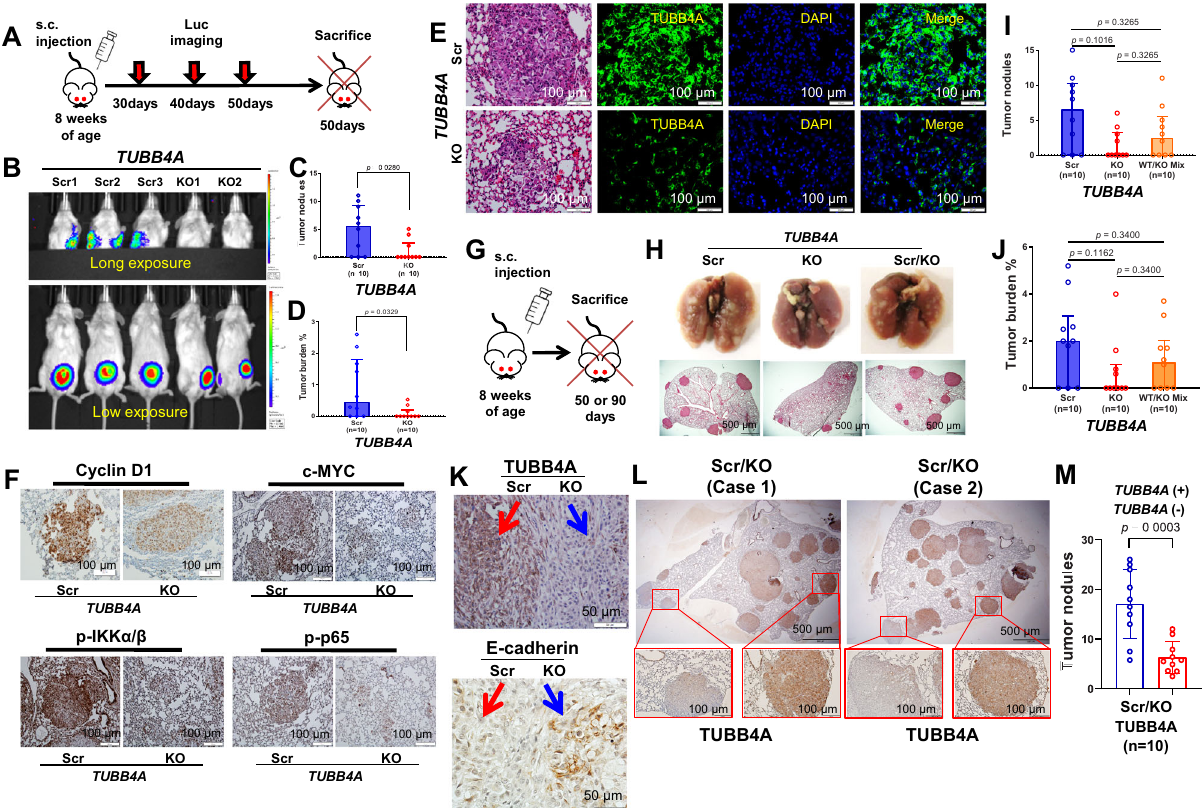
Fig. 7 TUBB4A KO decreases tumor metastasis in the lungs of NSG mice. A Schematic diagram of S.C. xenograft tumors followed for up to 50 days in NSG mice. B Luciferase imaging of xenograft tumors and metastases after implantation. C , D Statistical analysis of tumor nodules and burdens of lung metastasis at day 50. E H/E and IF staining of metastatic tumors. Scale bar, 100 μ m. F IHC staining of c-MYC, p-IKK α / β , and NF- κ B (p-p65) of lung metastatic tumors in DU145 xenografts. Scale bar, 100 μ m. G Schematic diagram of S.C. xenograft tumors followed for up to 90 days in NSG mice. H Representative tumor metastases in the lung at day 50. Scale bar, 500 μ m. I , J Statistical analysis of tumor nodules and burdens of lung metastasis at day 50. K IHC staining of TUBB4A and E-cadherin in scrambled/KO mixed S.C. xenografts. Scale bar, 50 μ m. L IHC staining of TUBB4A in scrambled/KO mixed lung metastatic tumors at day 90. Scale bar, 100 μ m or 500 μ m. M Statistical analysis of tumor nodules of lung metastasis at day 90. Data are replicated 10 times ( C , D , I , J , M ). Data are presented as the medians and interquartile ranges with a Mann – Whitney U ( C , D ) or Kruskal – Wallis followed by a Benjamini – Hochberg false discovery rate test for multiple comparisons ( I , J ). Data are presented as the means and SD with a two-tailed t test ( M ). Source data are provided as a Source data fi le. Scr, scramble; KO, knockout; s.c., subcutaneous injection; luc, luciferase. (Figs. S10B – E). The TUBB4A KO in tumor cells of the lung was con fi rmed by IF analysis (Fig. S10F). Likewise, expression of γ H2AX was increased in KO xenograft tumors compared to